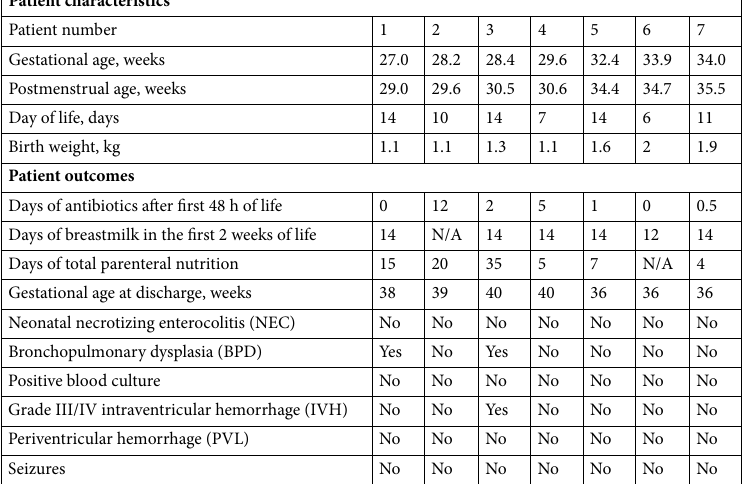
Table 1. Clinical characteristics of the donors of fecal